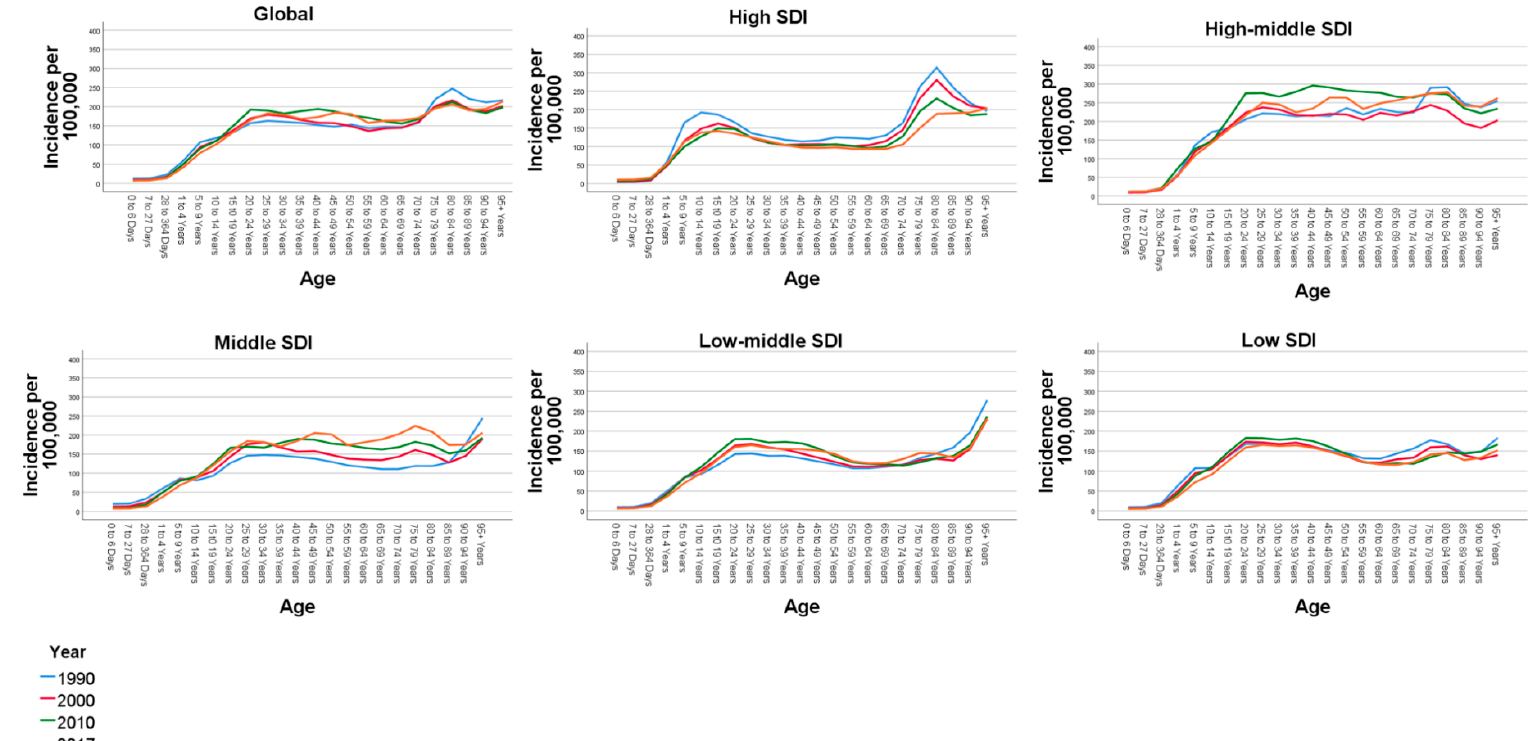
Figure2. Trendsforage-specificincidenceratesforpedestrianroadtra ffi cinjuriesper100,000acrosssociodemographicindices1990–2017. SDI:sociodemographicindex Figure 2. Trends for age-specific incidence rates for pedestrian road traffic injuries per 100,000 across sociodemographic indices 1990 – 2017. SDI: sociodemographic index .